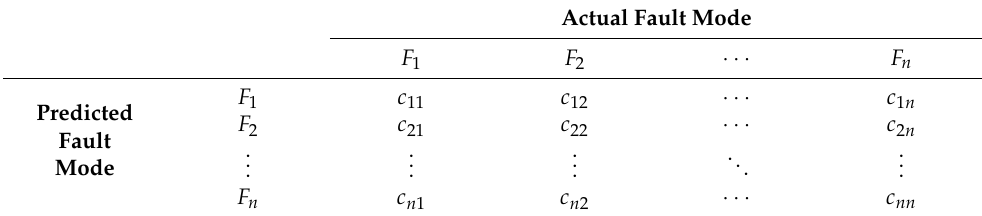
Table 1. n -fault modes’ misclassification cost